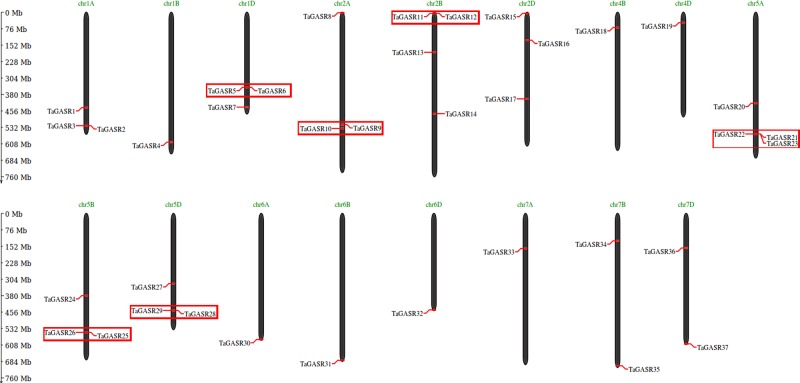
Chromosomal localization and gene duplication events of TaGASR genes. Respective chromosome numbers are indicated above each bar. Duplicated paralogous pairs of GASR genes in tandem duplication blocks are indicated by small boxes of the same color.